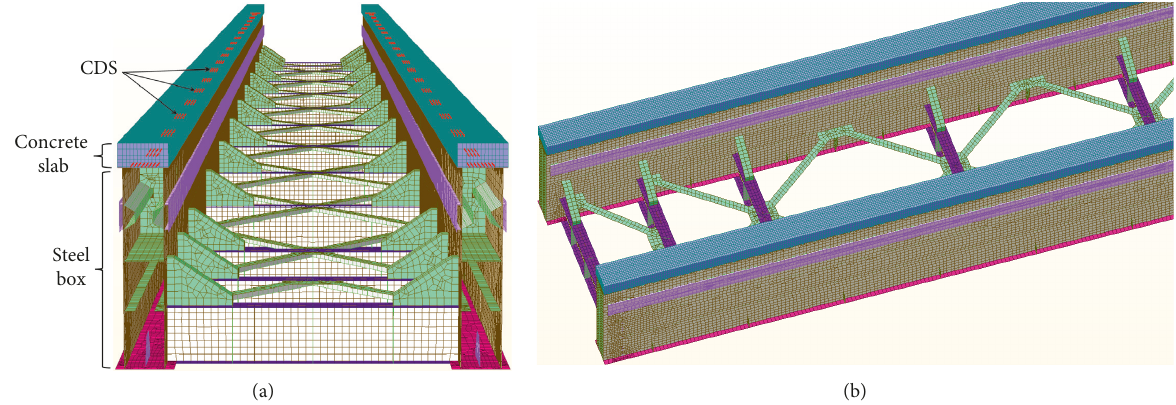
Figure 4: Detailed ANSYS FEM model. (a) Perspective view. (b) Aerial view.